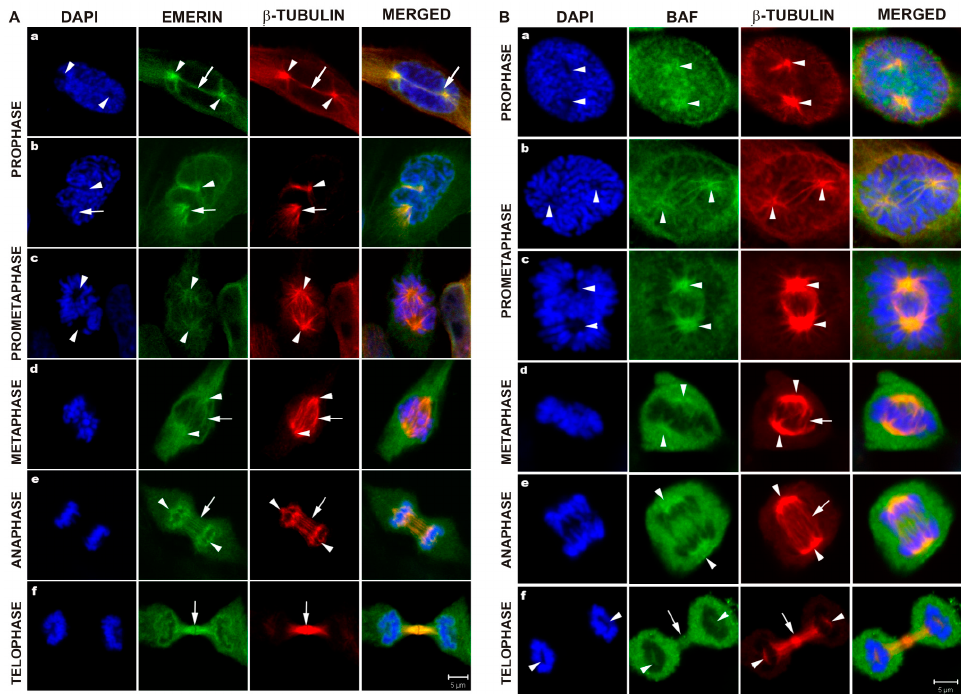
Figure 2. Cell cycle-dependent distribution of emerin and BAF in HeLa cells. ( A ) A fraction of emerin colocalizes with centrosomes and spindle microtubules during mitosis. Cells representing typical emerin phenotypes for particular mitosis stage were taken in order to demonstrate a fraction of emerin associated with mitotic spindle and centrosomes. Arrowheads indicate the position of centrosomes (a–e), arrows indicate the spindle microtubule (a,b,d,e) and midbody (f). ( B ) Emerin binding partner BAF colocalizes with centrosomes and spindle microtubules. Arrowheads indicate the position of centrosomes (a–f), arrows indicate spindle microtubule (d,e) and midbody (f). Note the change in staining character for BAF from “grainy” (a–c) to “smooth” (d–f). Note the colocalization between polar microtubule and emerin very clearly visible between centrosomes (A, a, arrow) and nuclear envelope invagination (A, b, arrow) associated with centrosomes and astral microtubules in NE invaginations. Arrows point to microtubules associated with emerin. HeLa cells were stained with antibodies against emerin (green, A), BAF (green, B), and β -tubulin (red). Single Z-stacks, 1.5 µ m through cell nucleus or mitotic spindle centered at the centrosomes were visualized. Scale bar, 5 μ m.